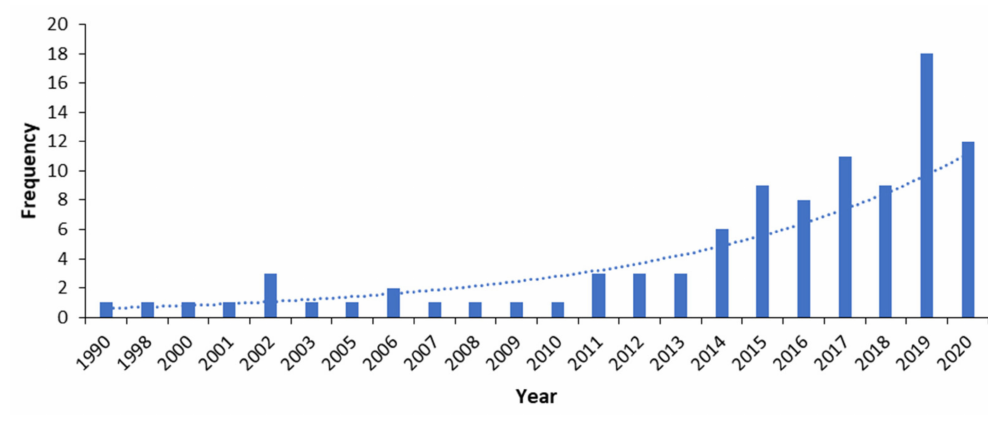
Figure 1. Number of research articles per year.